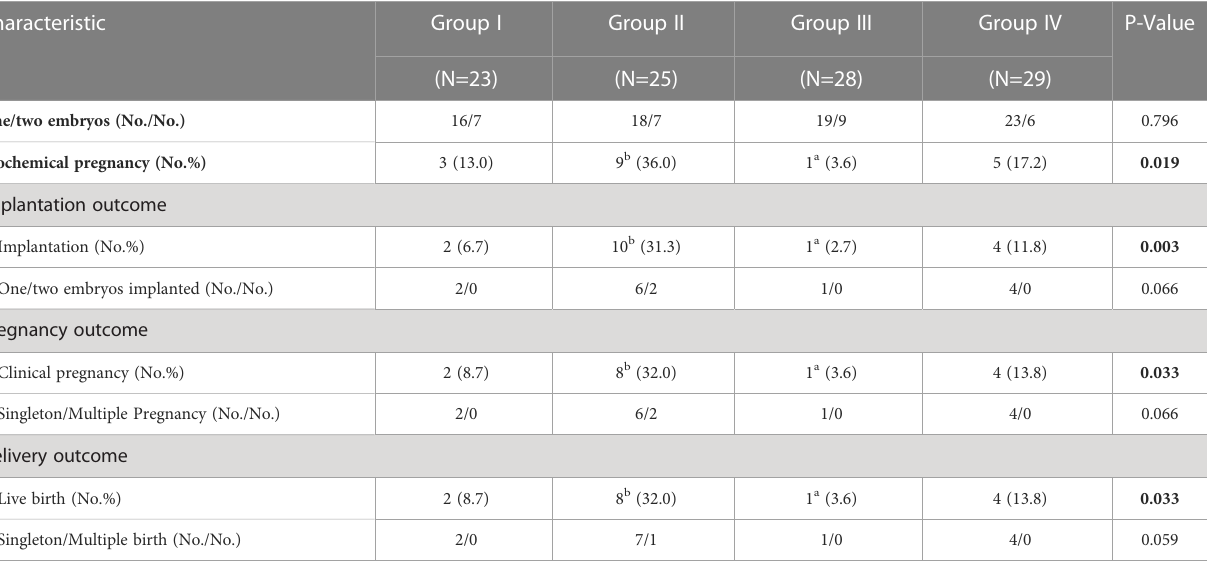
TABLE 3 Clinical outcomes of transfer